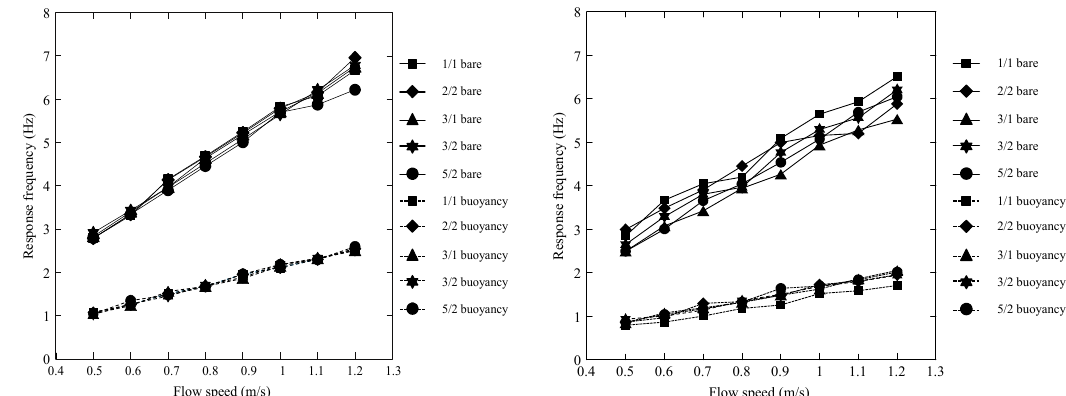
Figure 8. Excited response frequencies for five configurations at flow speeds between 0.5–1.2 m/s. ( Left ): prediction using the default set of excitation coefficients from VIVANA; ( Right ): measured response frequencies from Shell Test.